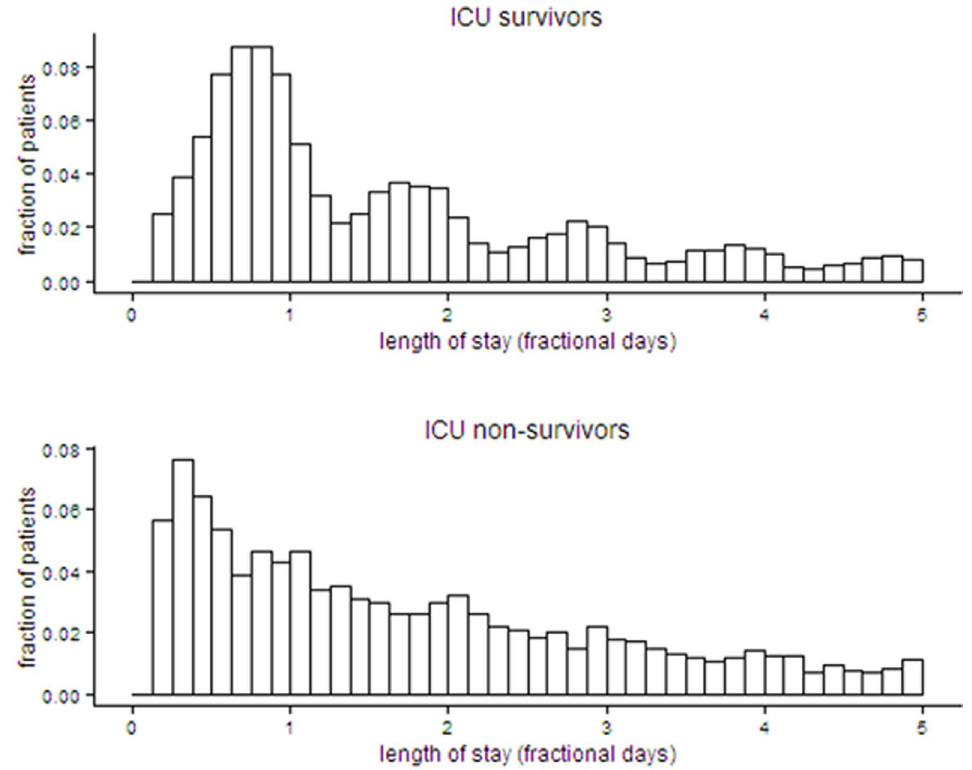
Figure 1. Distribution of ICU LoS for survivors and non-survivors.